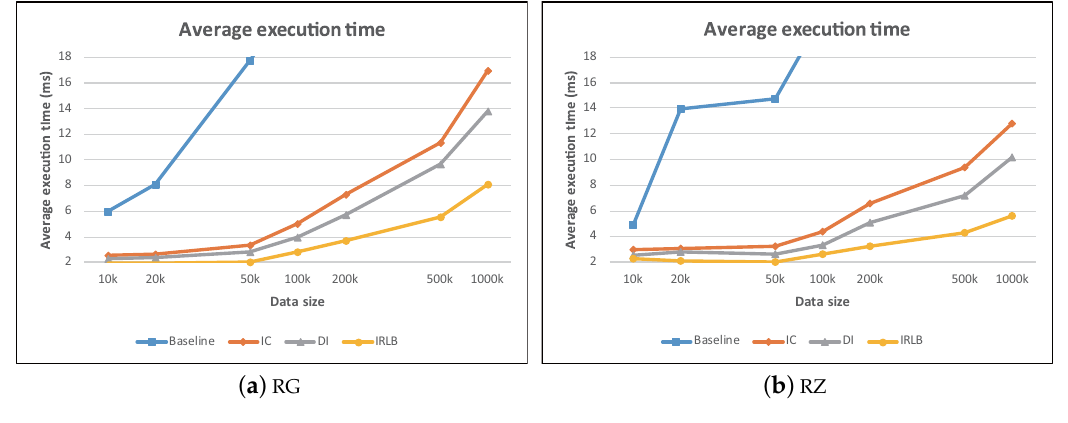
Figure 24. Average execution time vs. | P |